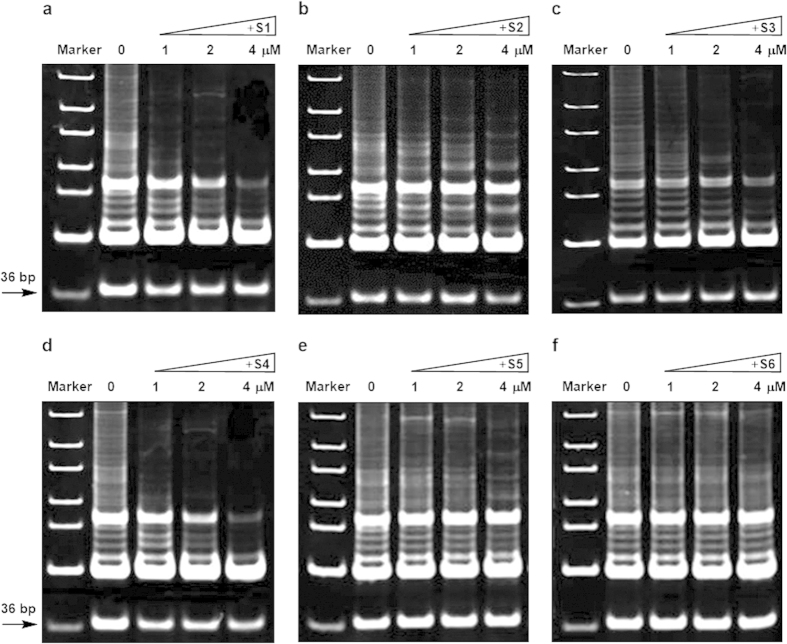
Effect of benzothioxanthene derivatives on the telomerase activity in A549 cells.Cell extracts containing telomerase and TRAP assay reagents were mixed and the activity of telomerase was determined in the presence of 0, 1, 2, or 4 μM S1–S6 (a–f). The arrow indicates the 36 bp internal control.